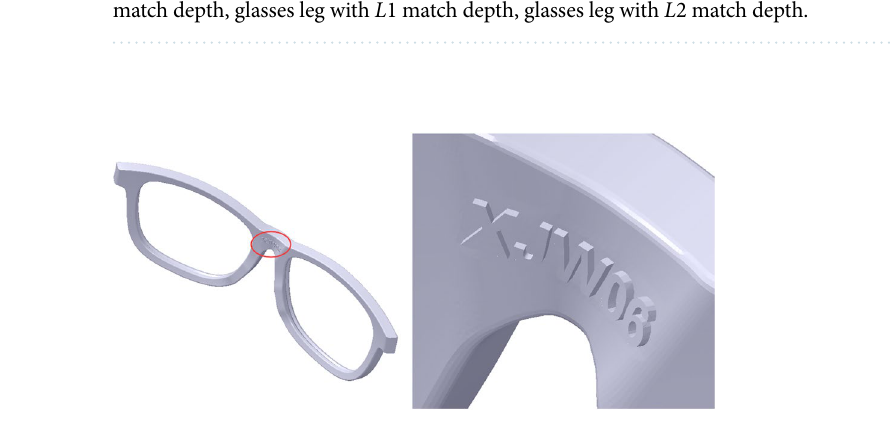
Figure 23. A series of glasses leg. From left to right: glasses leg with L variable match depth, glasses leg with L 0 match depth, glasses leg with L 1 match depth, glasses leg with L 2 match depth.